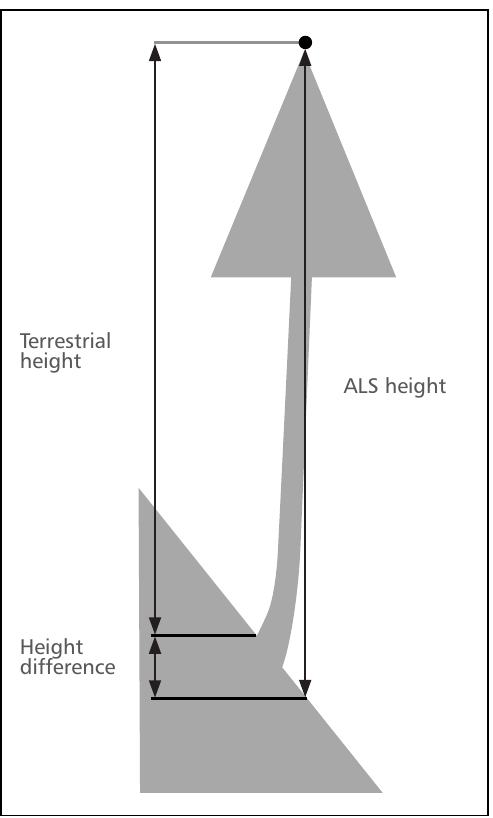
FIGURE 3. Difference between terrestrial derived and ALS derived tree height on steep slope. Terrestrial tree height is defined as the vertical distance from the tree apex to the up-slope base of the tree. The ALS tree height is usually calculated as the maximum value of the Canopy Height Model within the crown area [83].